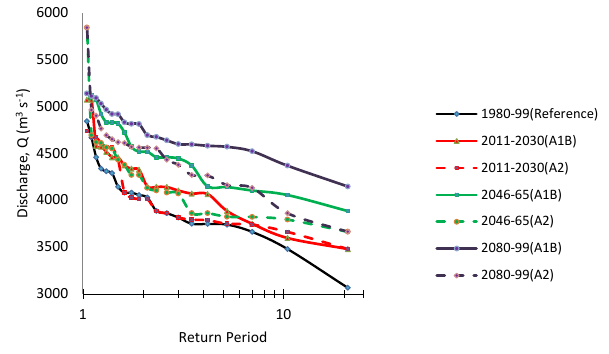
Fig. 8. Box-whisker plot for yearly average 7-day low flow for A1B Scenario of 12 different weighted hydrological model outputs.